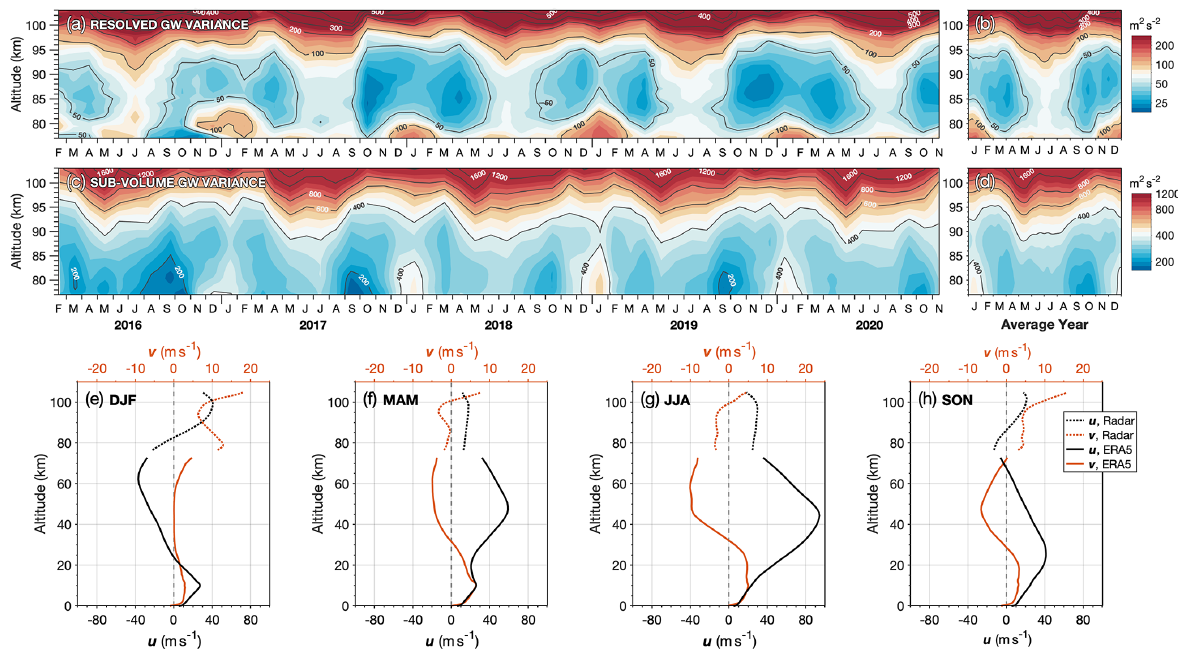
Figure 7. Wind variance against height due to gravity waves (GWs) for (a, b) large-scale “resolved” GWs in the derived winds and (b, c) small-scale “sub-volume” GWs. Panels (e) – (h) show seasonal averages of zonal u (black, lower axis) and meridional v (orange, upper axis) winds against height from ERA5 reanalysis (solid) and the meteor radar (dotted) over South Georgia for the period 2016 to